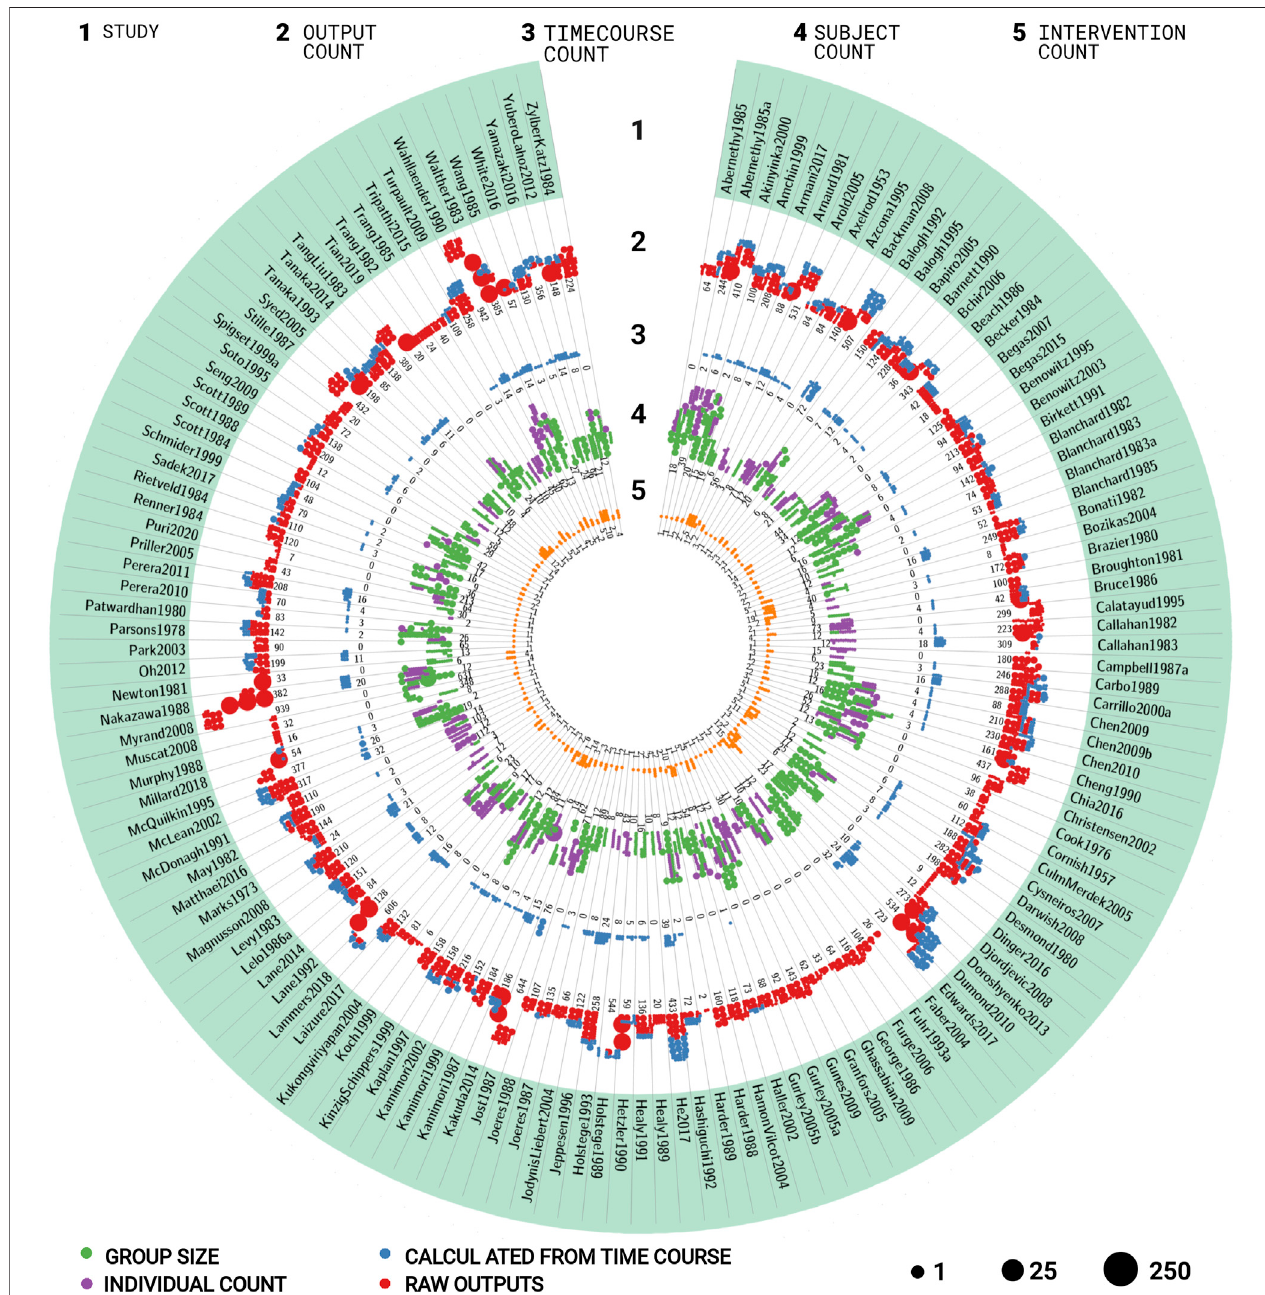
FIGURE 2 | Overview of studies in the caffeine pharmacokinetics data set. The data set consists of 141 studies containing 500 groups, 4,714 individuals, 387 interventions,24,571outputs,and846time-courses.Thecircularplotisstructuredinstripesandrings.Eachstriperepresentsadifferentstudy,eachringtheamountof differentdatatypesfortherespectivestudy.Thedotsrepresenttherespectiveamountofdatawiththedotsizecorrespondingtothenumberofentriesperdot.Therings contain the following information for the respective study (A) name of the study; (B) number of outputs (pharmacokinetics parameters and other measurements). Red dots represent reported data, blue dots data calculated from time-courses reported in the study; (C) number of time-courses; (D) number of participants. Purple dots represent participants with individual data, green dots represent collectively reported participants; (E) number of interventions applied to the participants in the study. For additional information see Table 1 .